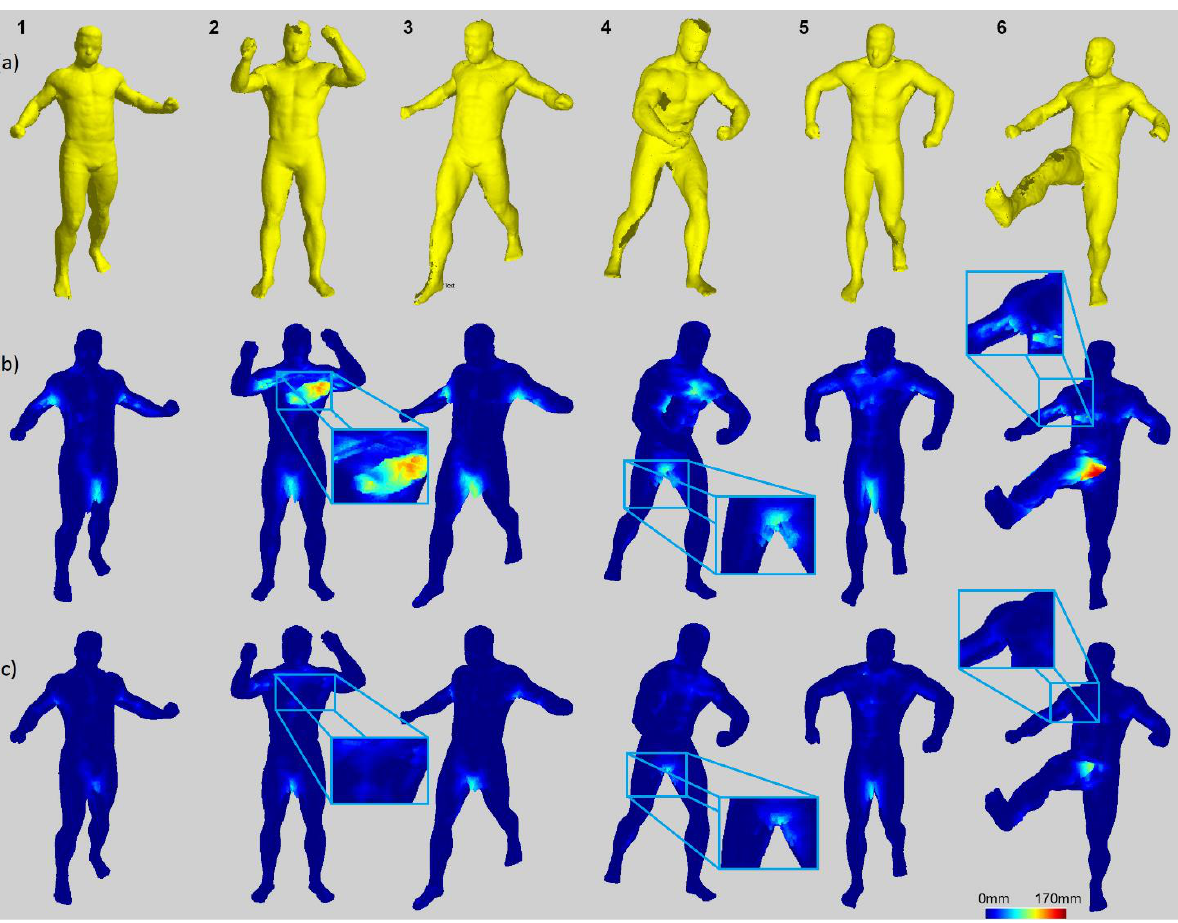
Figure 9. Visualization of P2S distances for SfS and sSfS results: ( a ) SfM; ( b ) SfS with P2S error map; ( c ) sSfS with P2S error map. Each data sample in the column corresponds to a data sample from Table A1; the numbers at the top of each column relate to the data sample ID.